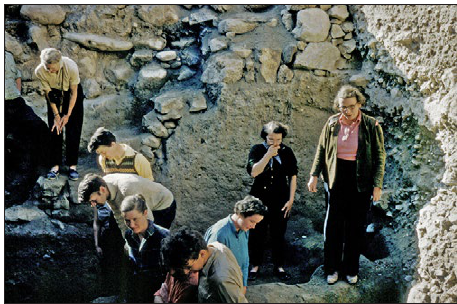
Figure 1: Kathleen Kenyon excavation at Jericho. Photo: Stuart Laidlaw. Reproduced with permission of the photography. Insti- tute of Archaeology Jericho Photographic